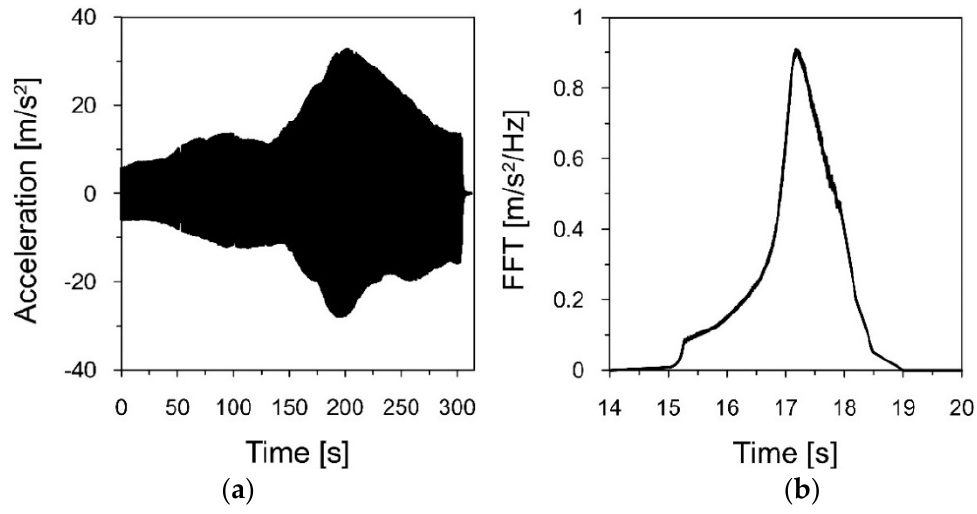
Figure 15. ( a ) The acceleration − time history of the model vibrations, caused by a linear sweep in the range of 15–18 Hz, registered at the top of the model; ( b ) the Fourier spectrum of the signal.